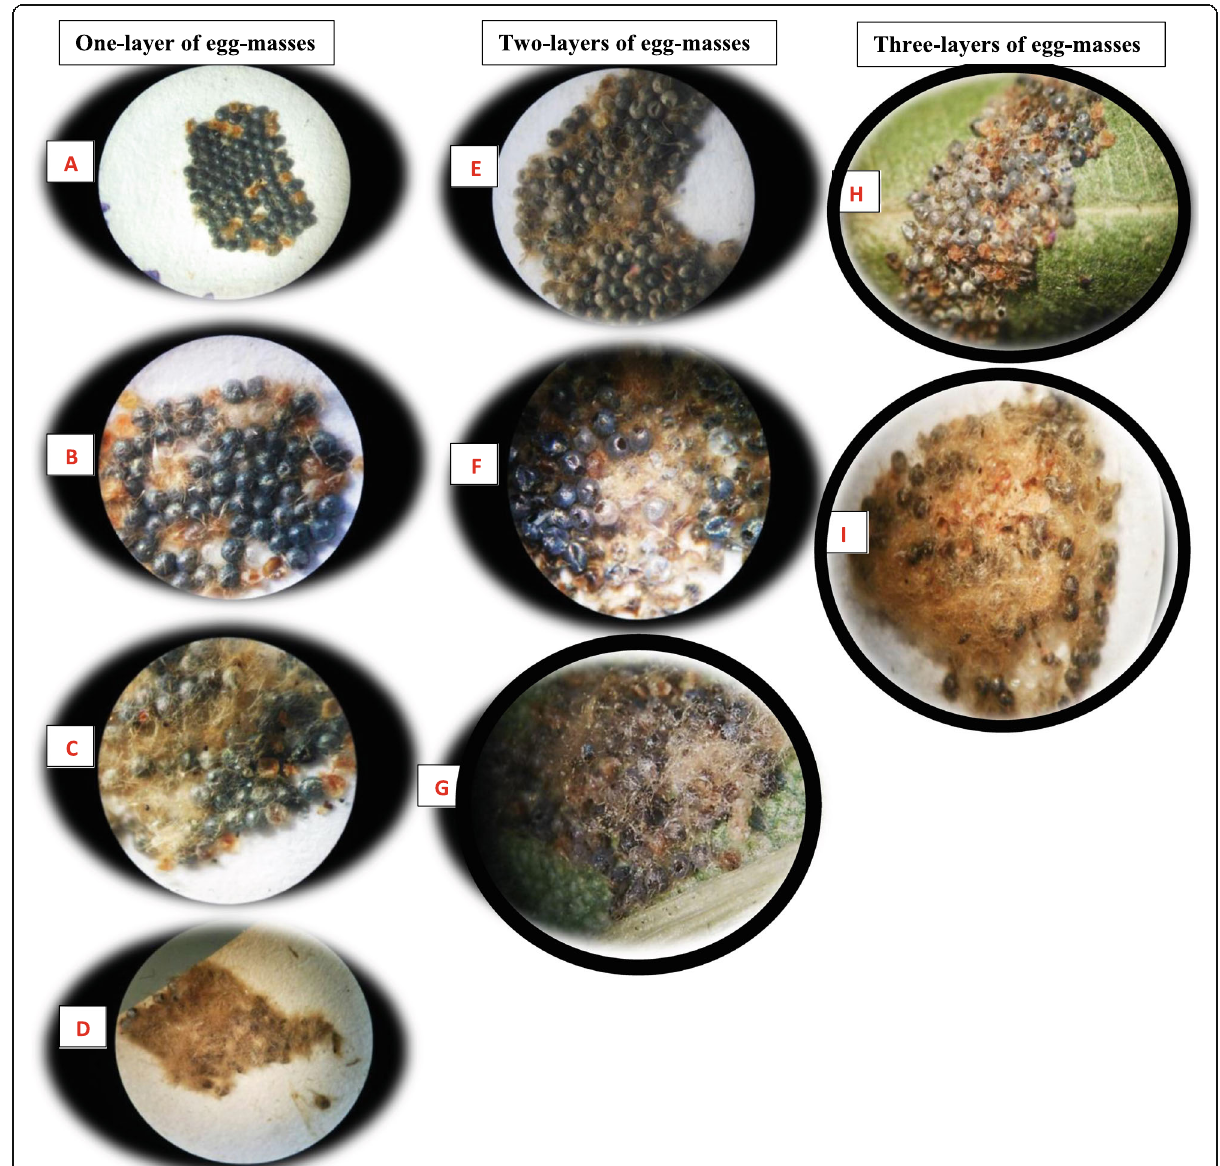
Fig. 1 Parasitism of T. bactrae on S. littoralis egg masses with different physical characteristics: a 1 layer with no scales, b with low scale density, c with mid scale density, d with high scale density, e 2 layers with low scale density, f with mid scale density, g with high scale density, h 3 layers with low scale density, i with high scale